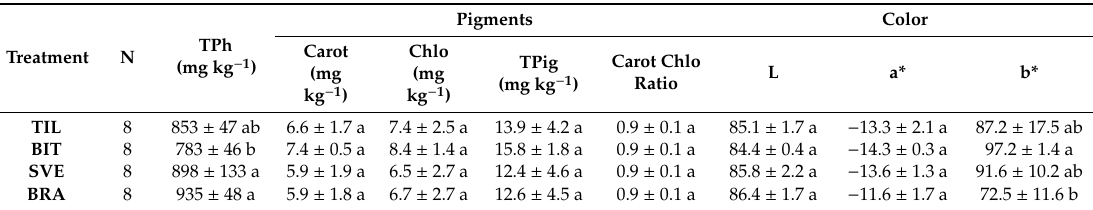
Table 7. Olive oil parameters for the di ff erent treatments in